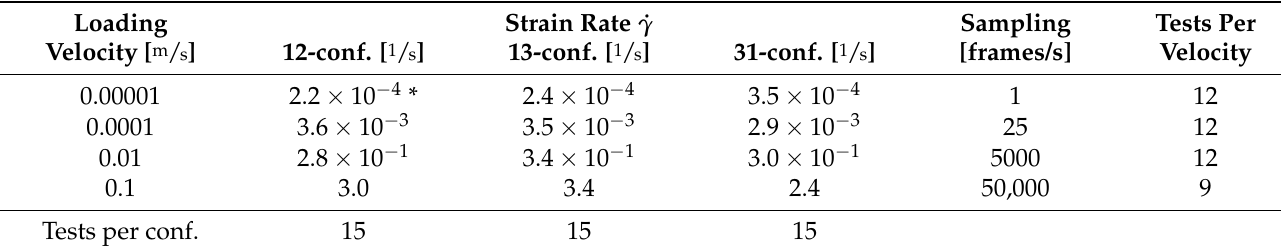
Table 1. Overview of the conducted tests.